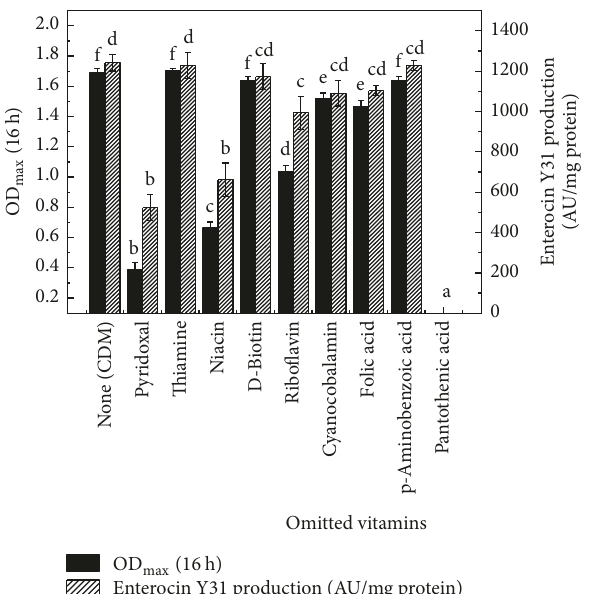
Figure 3: Effect of individually omitting each B vitamin on the growth of Enterococcus faecium Y31 and Enterocin Y31 production. Means not sharing a common superscript letter are significantly different from each other ( 𝑃 < 0.05 ).